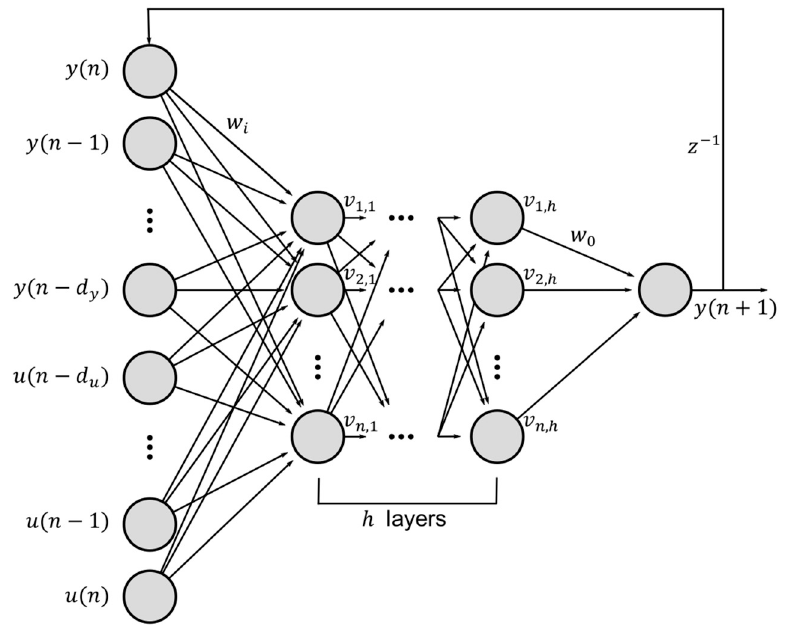
Figure 3. The architecture of Nonlinear Autoregressive model with eXogenous input (NARX) neural network used in this study to backcast GRACE derived TWS and TWSC as well as GLDAS-Noah TWC and TWCC for validation purposes. Adapted from [40].